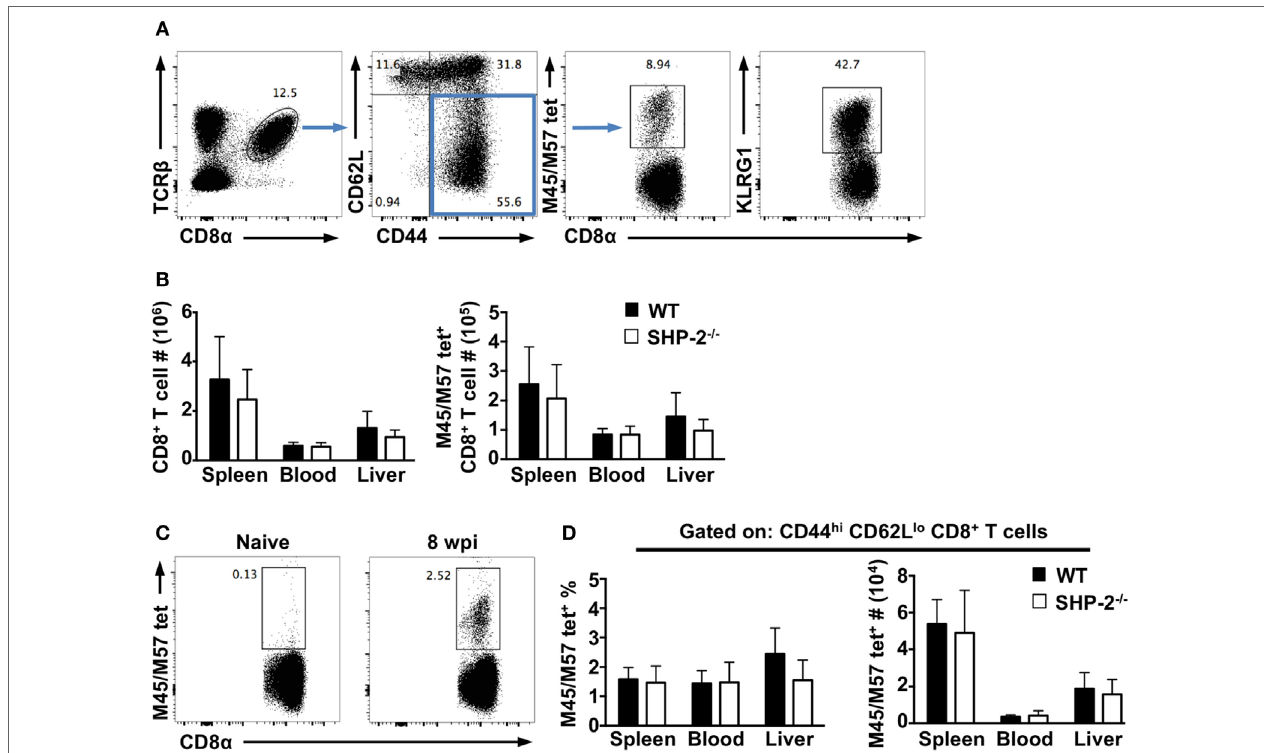
FigUre 3 | Src homology region 2 domain-containing phosphatase-2 (SHP-2) does not affect early immune responses and memory CD8 + T cell differentiation during murine cytomegalovirus (MCMV) infection. (a) Representative FACS plots show staining of CD8 + T cells and m45/57tet + CD8 + T cells at day 7 postinfection. (B) The absolute numbers of CD8 + T cells and m45/57tet + CD8 + T cells at day 7 postinfection. n = 10 wild-type (WT) and 8 SHP-2 − / − mice over two independent experiments. Graphs show mean and SD. (c) Representative FACS plots show staining for antigen-specific CD8 + T cells in naïve and infected WT mice. (D)